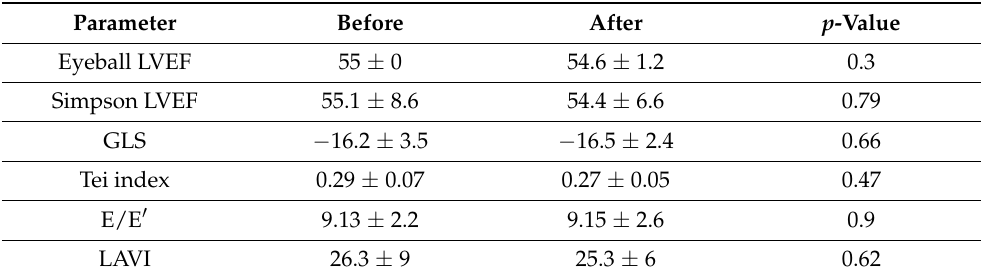
Table 1. Echocardiographic parameters before and after caspofungin infusion. Parameter Before After p